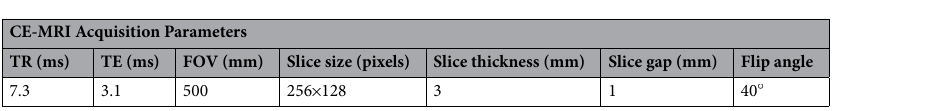
Table 1. Acquisition parameters of CE-MRI sequences. TR: repetition time; TE: echo time; FOV: field of view.